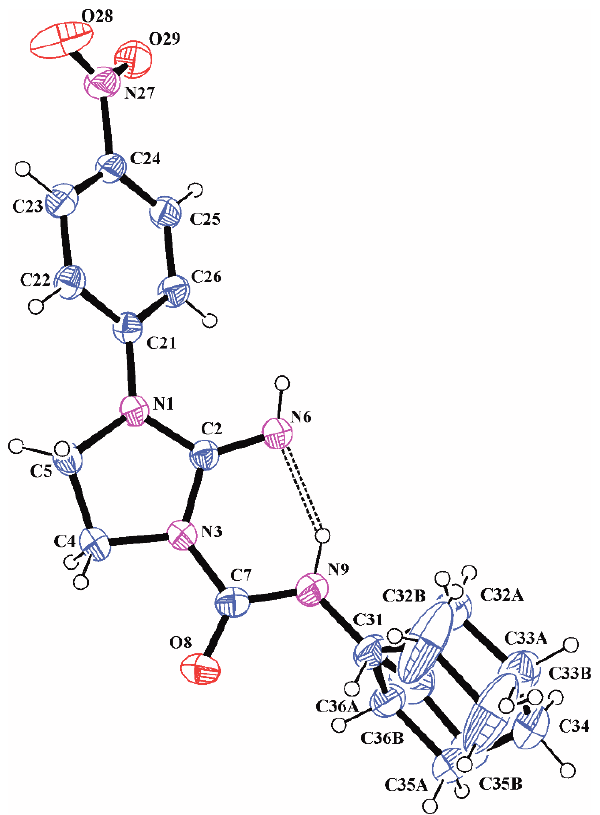
Figure 2. A view of the molecule 4f with the atom labelling. Non-H atoms are represented by displacement ellipsoids at the 30% probability